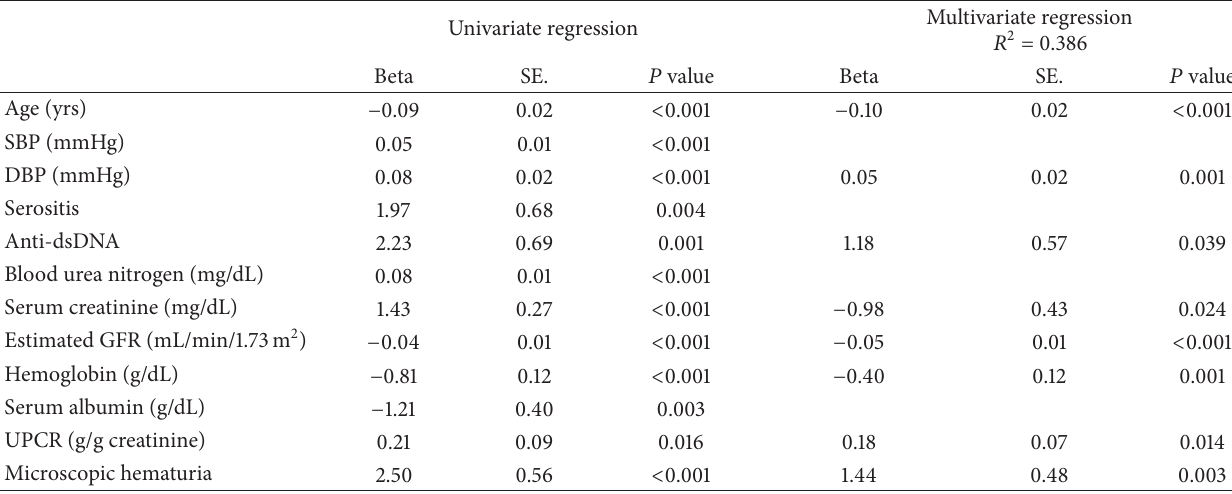
Table 4: Univariate and multivariate regression analyses demonstrating clinical factors showing correlation with renal pathological activity index (AI).